Question: From the figure, is the trend upward or downward?
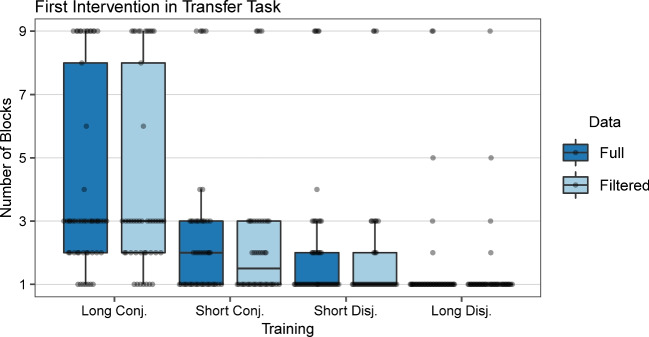
Answer: increasing